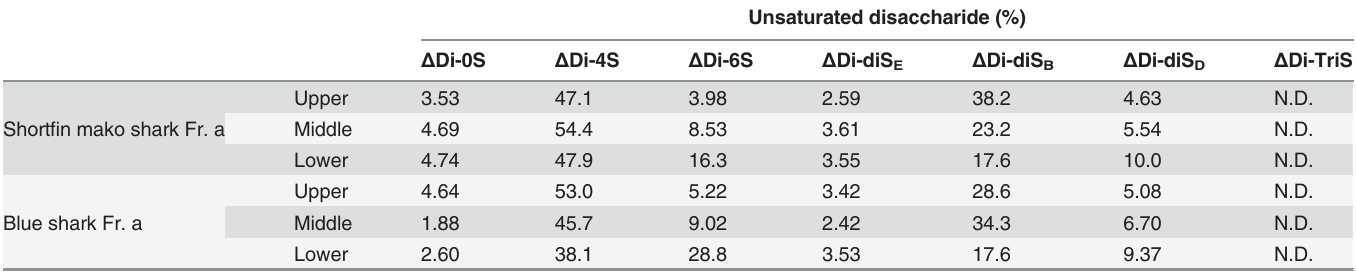
Table 1. Unsaturated disaccharide compositions of oligosaccharides containing IdoA-rich domain at the different molecular weight.